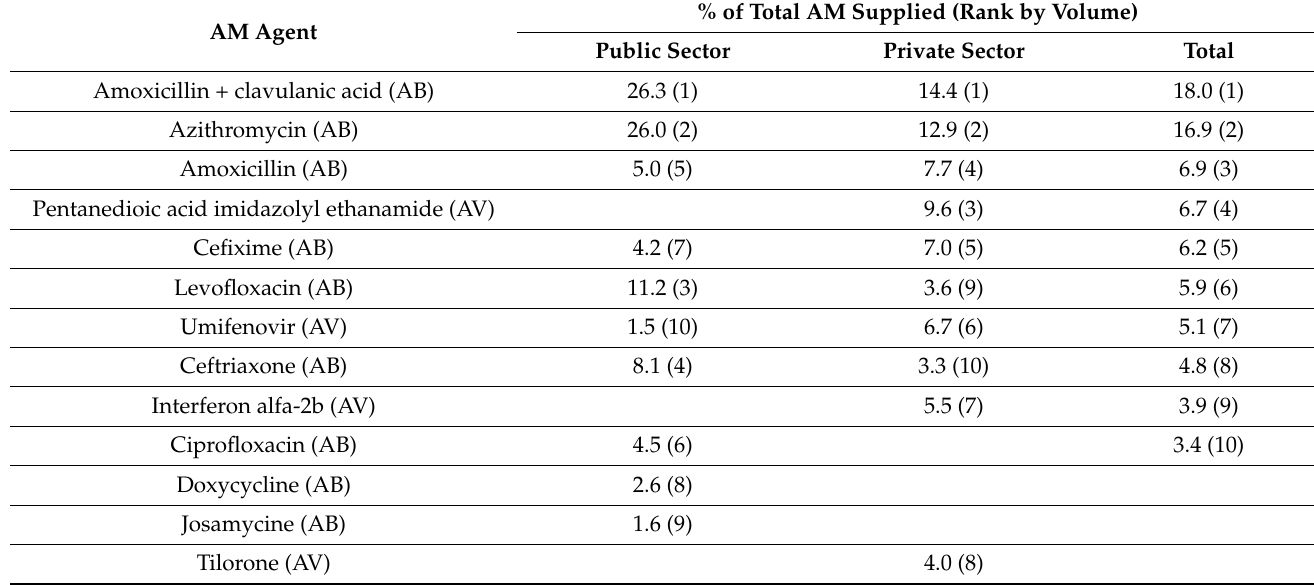
Table 7. Top 10 AM agents supplied for URTI in community